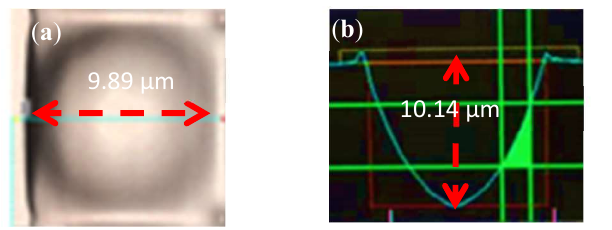
Figure 20. Sectional measurement of a concave PSMLA microstructure sample: ( a ) top view; ( b ) side view.